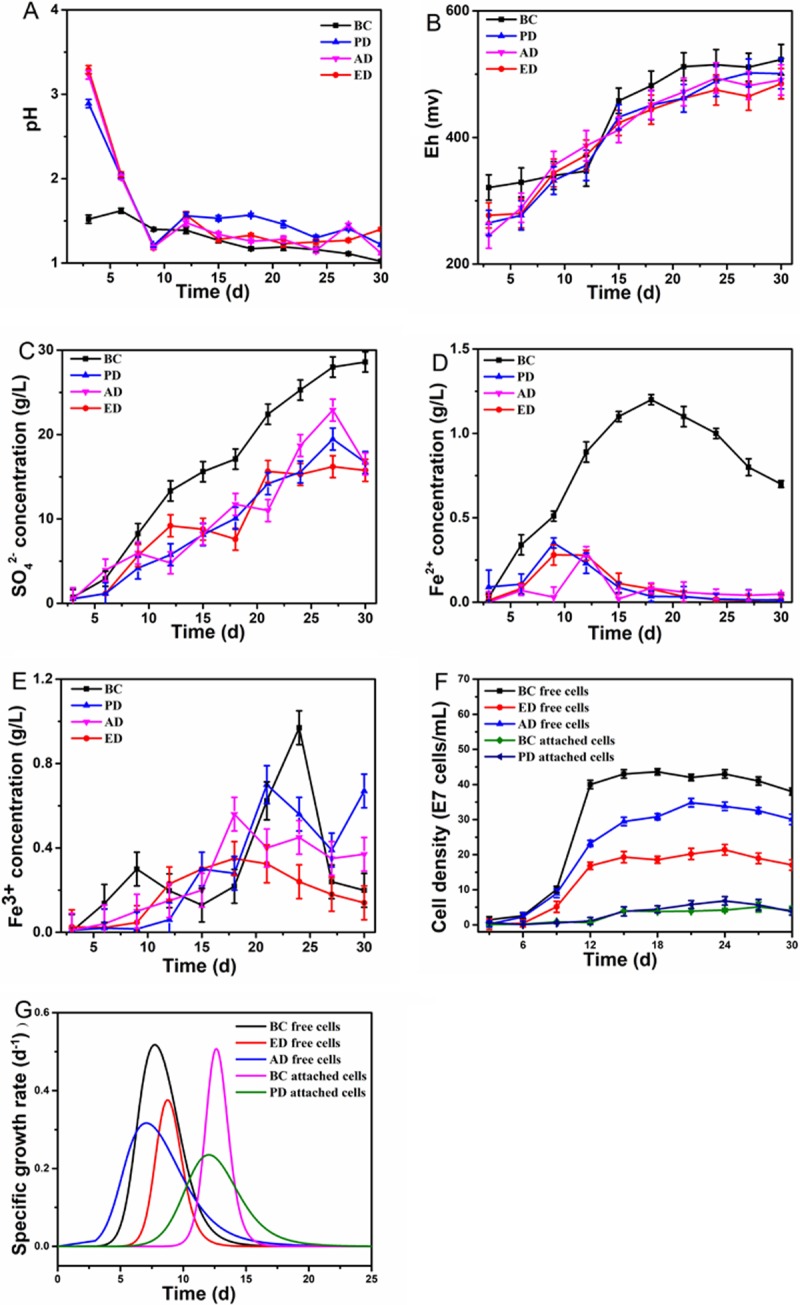
Changes in key chemical parameters in different deficient bioleaching systems.(A): pH; (B): Eh; (C): Sulfate ions; (D): Ferrous ions; (E): Ferric ions; (F) Planktonic and attached biomass; (G) μx of planktonic and attached cells. Note: the pH of leachate during bioleaching was measured before the pH-1.5 adjustment by 6 M HCl every two days.